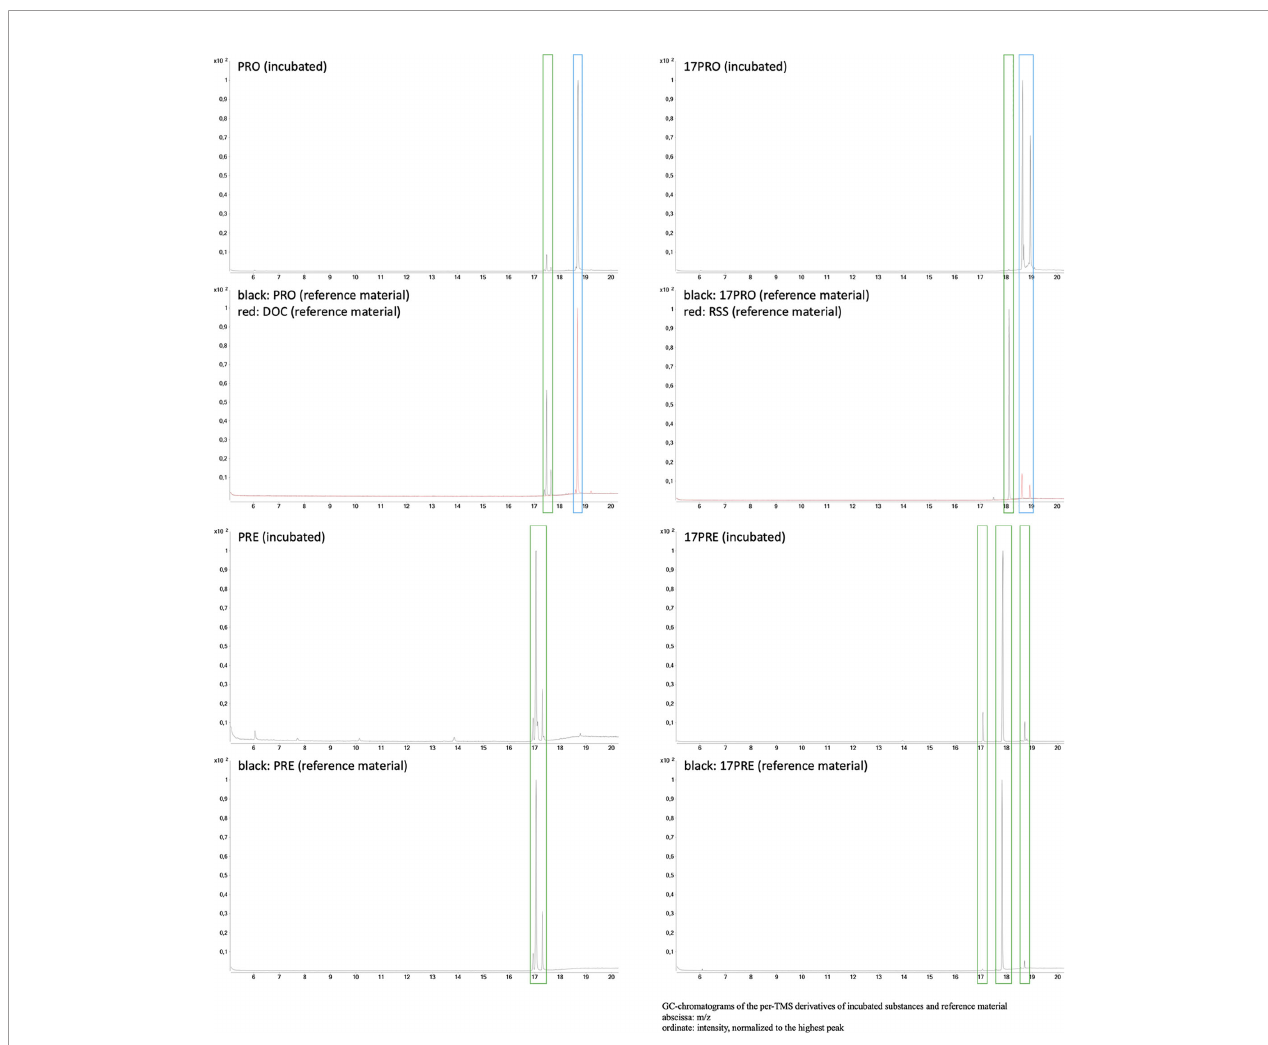
FIGURE 2 | Upper two rows: Chromatograms (GC-EI-MS) of the TMS derivatives of progesterone (PRO), 17-hydroxyprogesterone (17PRO), and their hydroxylated products after incubation in comparison to the authentic reference material (due to the formation of derivatization isomers, multiple peaks are obtained for one analyte). Lower two rows: Chromatograms (GC-EI-MS) of the TMS derivatives of pregnenolone (PRE) and 17-hydroxypregnenolone (17PRE) after incubation in comparison to the authentic reference material (due to the formation of derivatization isomers, multiple peaks are obtained for one